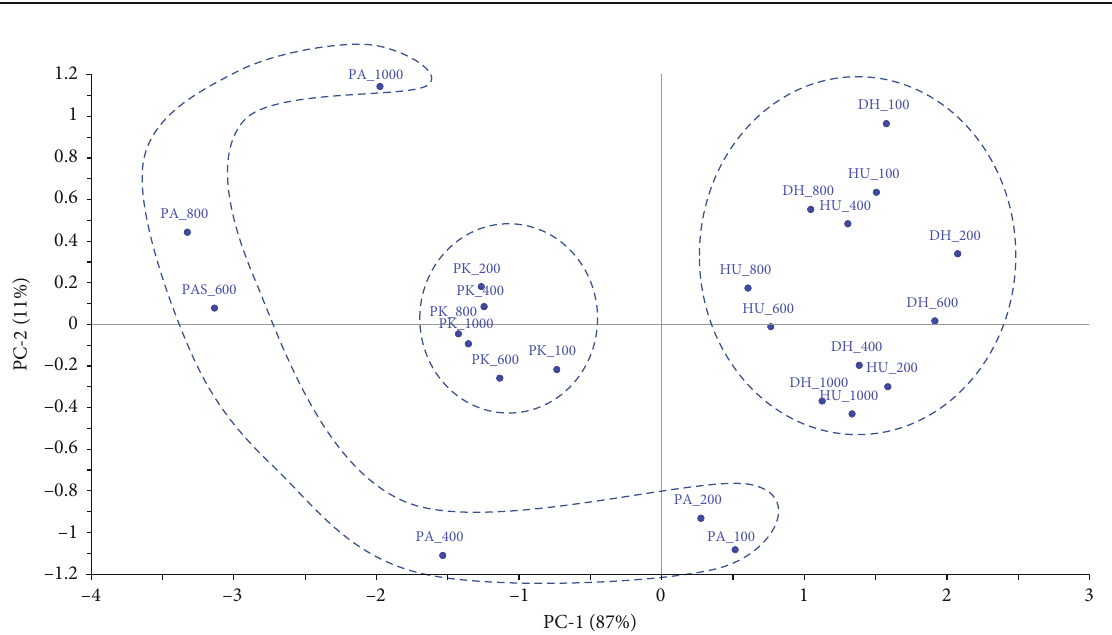
Figure 1: Principal component analysis (PCA) score plot for measured contaminated cheese samples showing the concentration of four species using electronic nose (EN). Pichia anomala (PA), Pichia kluyveri (PK), Debaryomyces hansenii (DH), and Hanseniaspora uvarum (HU). Each name in the fi gure is followed by the concentration in